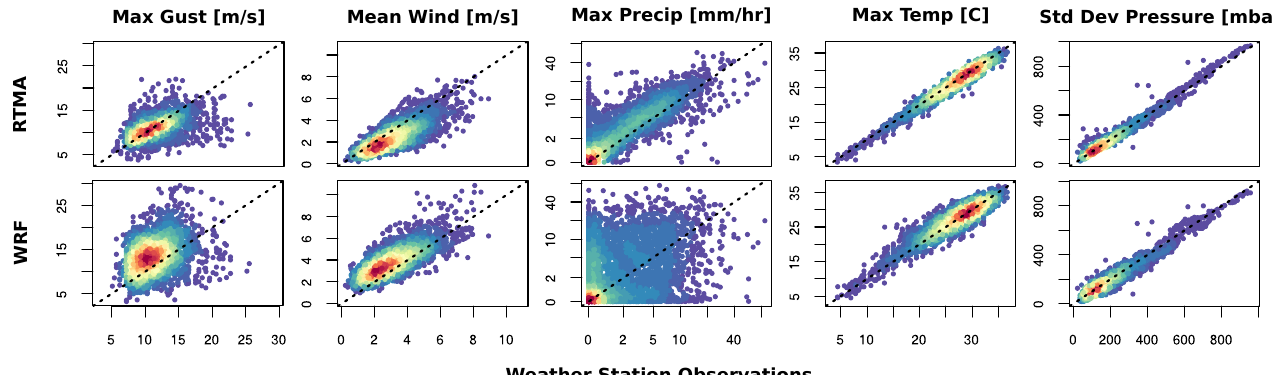
Figure 2. Point-to-point comparison of the NOAA analysis parameters (RTMA, ( Top )) and the WRF simulation parameters (WRF, ( Bottom )) versus weather station observations for select variables, describing 24 h thunderstorm events.